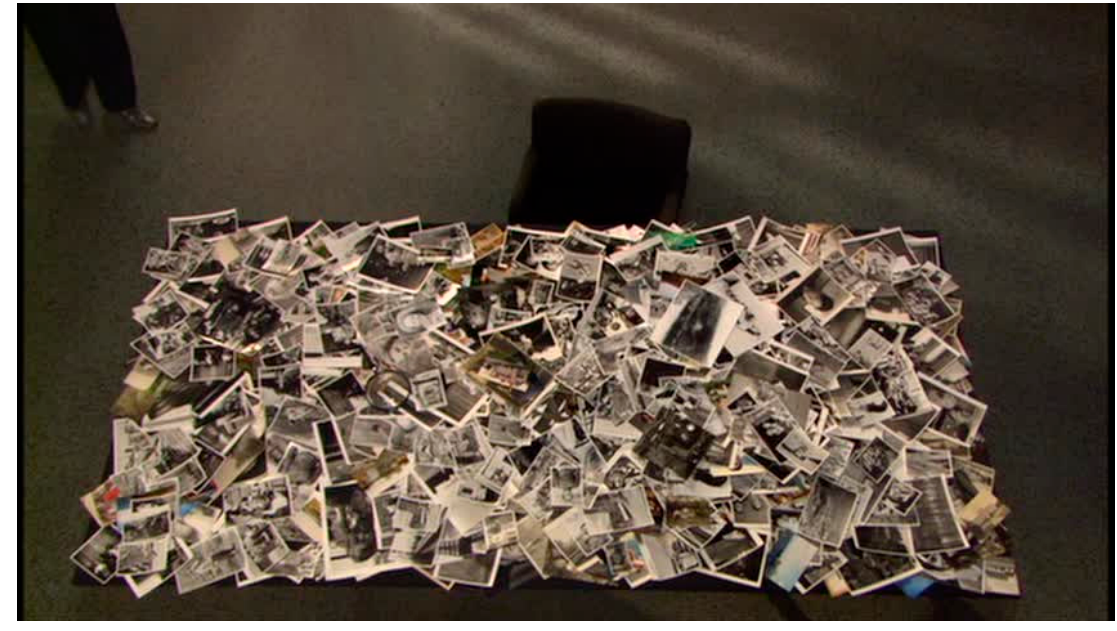
Figure 15. Marianne, her photos, and us.